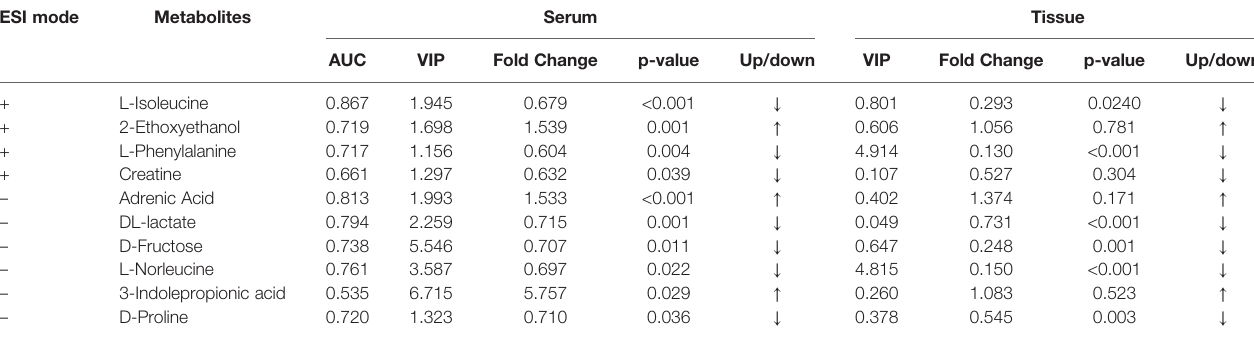
TABLE 2 | List of potential metabolites presented the same expression levels both in serum and tissue samples of stage-I PDAC patients. ESI mode